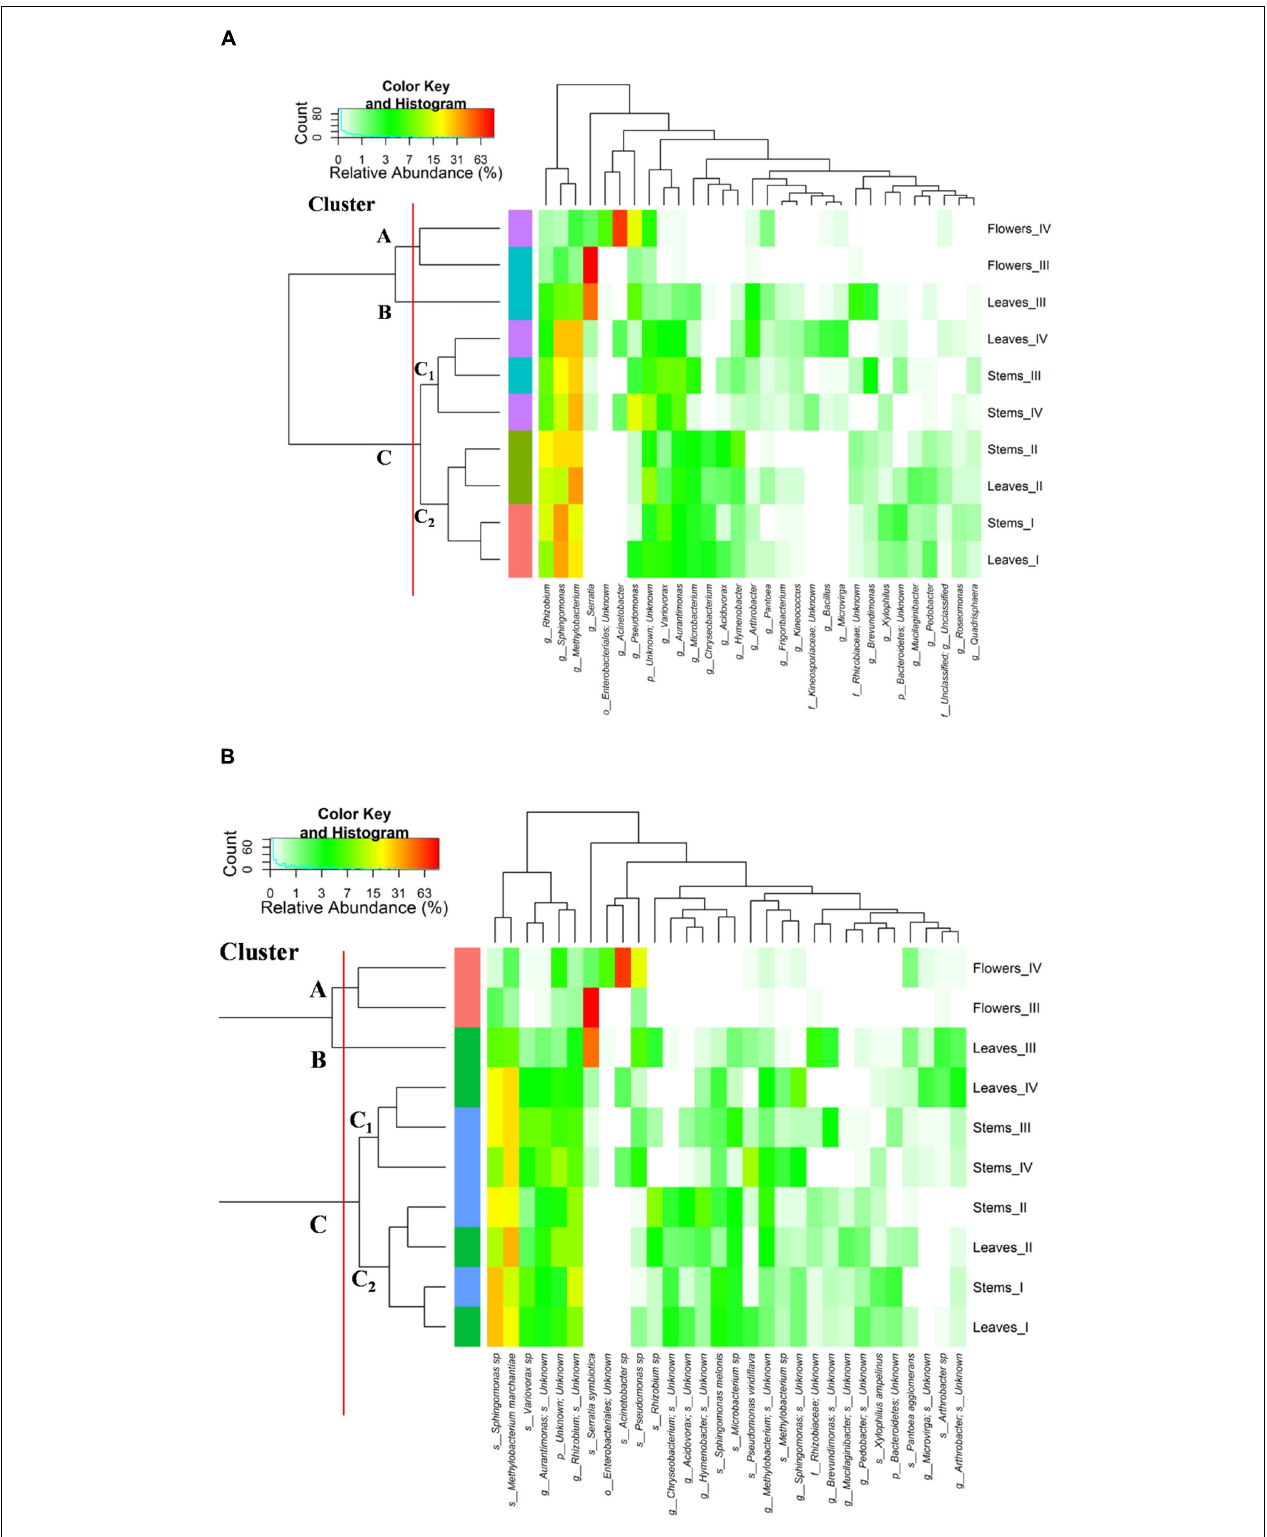
FIGURE 3 | Pseudo heat map summarizing the relative abundances of the 30 most dominant genera (A) and species (B) in DNA samples directly extracted from epiphytic bacteria found on leaves, stems and flowers of Origanum vulgare L. plant during the early vegetative (I), late vegetative (II), blooming (III) and full-flowering (IV) stages. The color key defines the percentages of OTUs in the